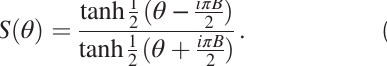
FIG. 3. The functions β 2 β 10 − p , with p ¼ 0 (stars), 1 (triangles), 2 (inverted trian- L ¼ gles), 3 (squares), and 4 (circles). The continuous bold line represents the conformal value β 2 expected, is reached at high temperatures. Dashed curves are